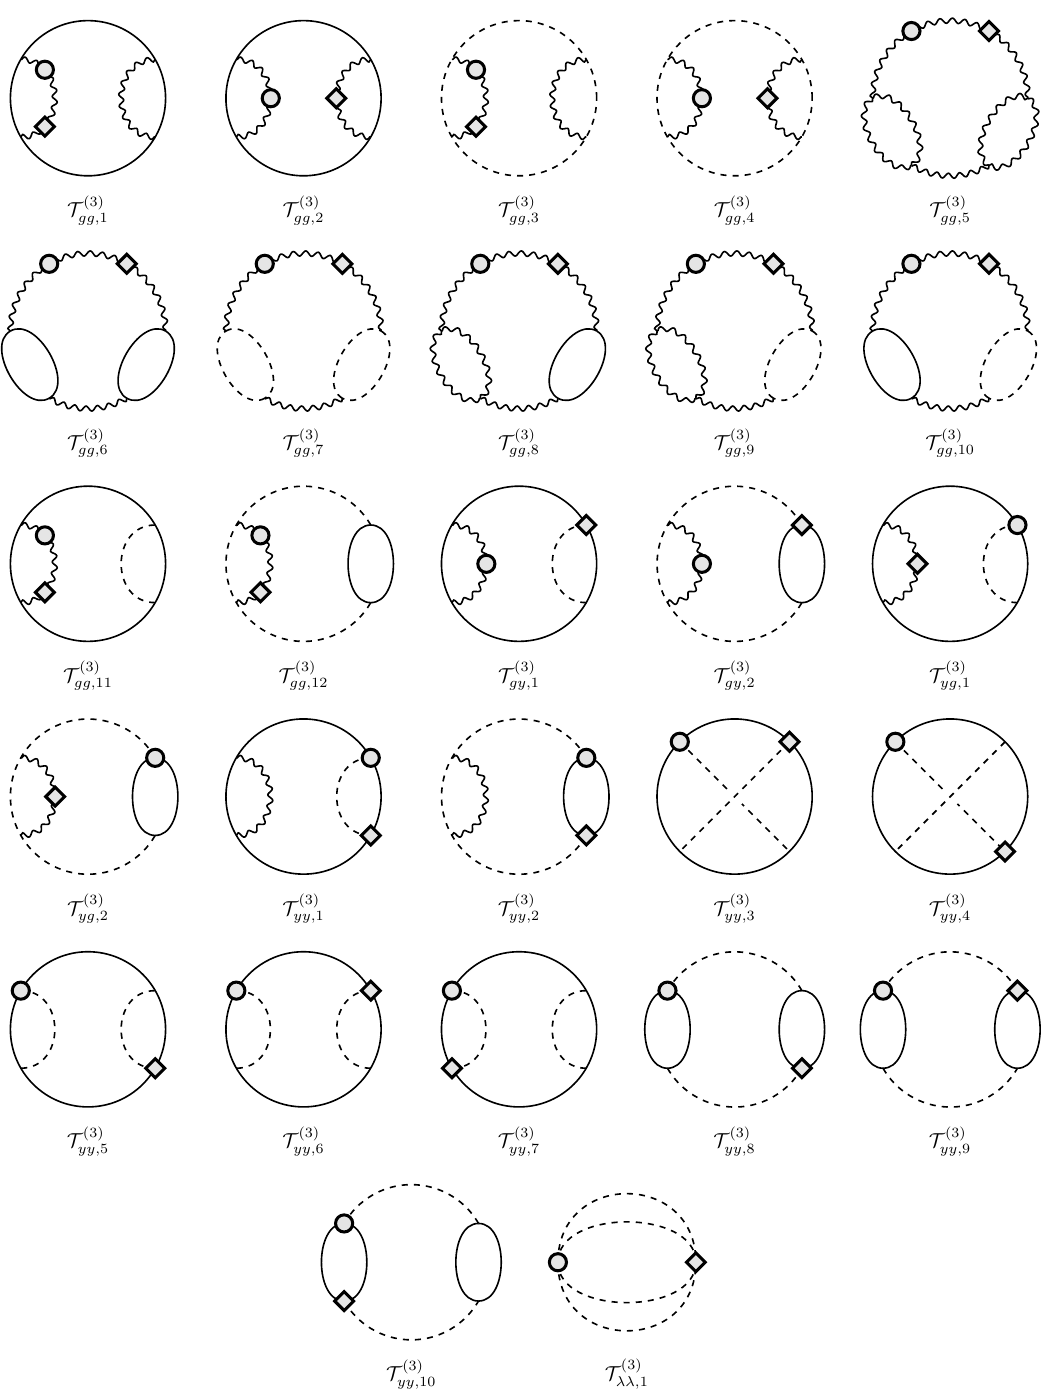
Figure 9 . Graph representation of the 27 3-loop contributions to the metric T an open index I and a diamond an index J . Note that the scalar lines in intersect.